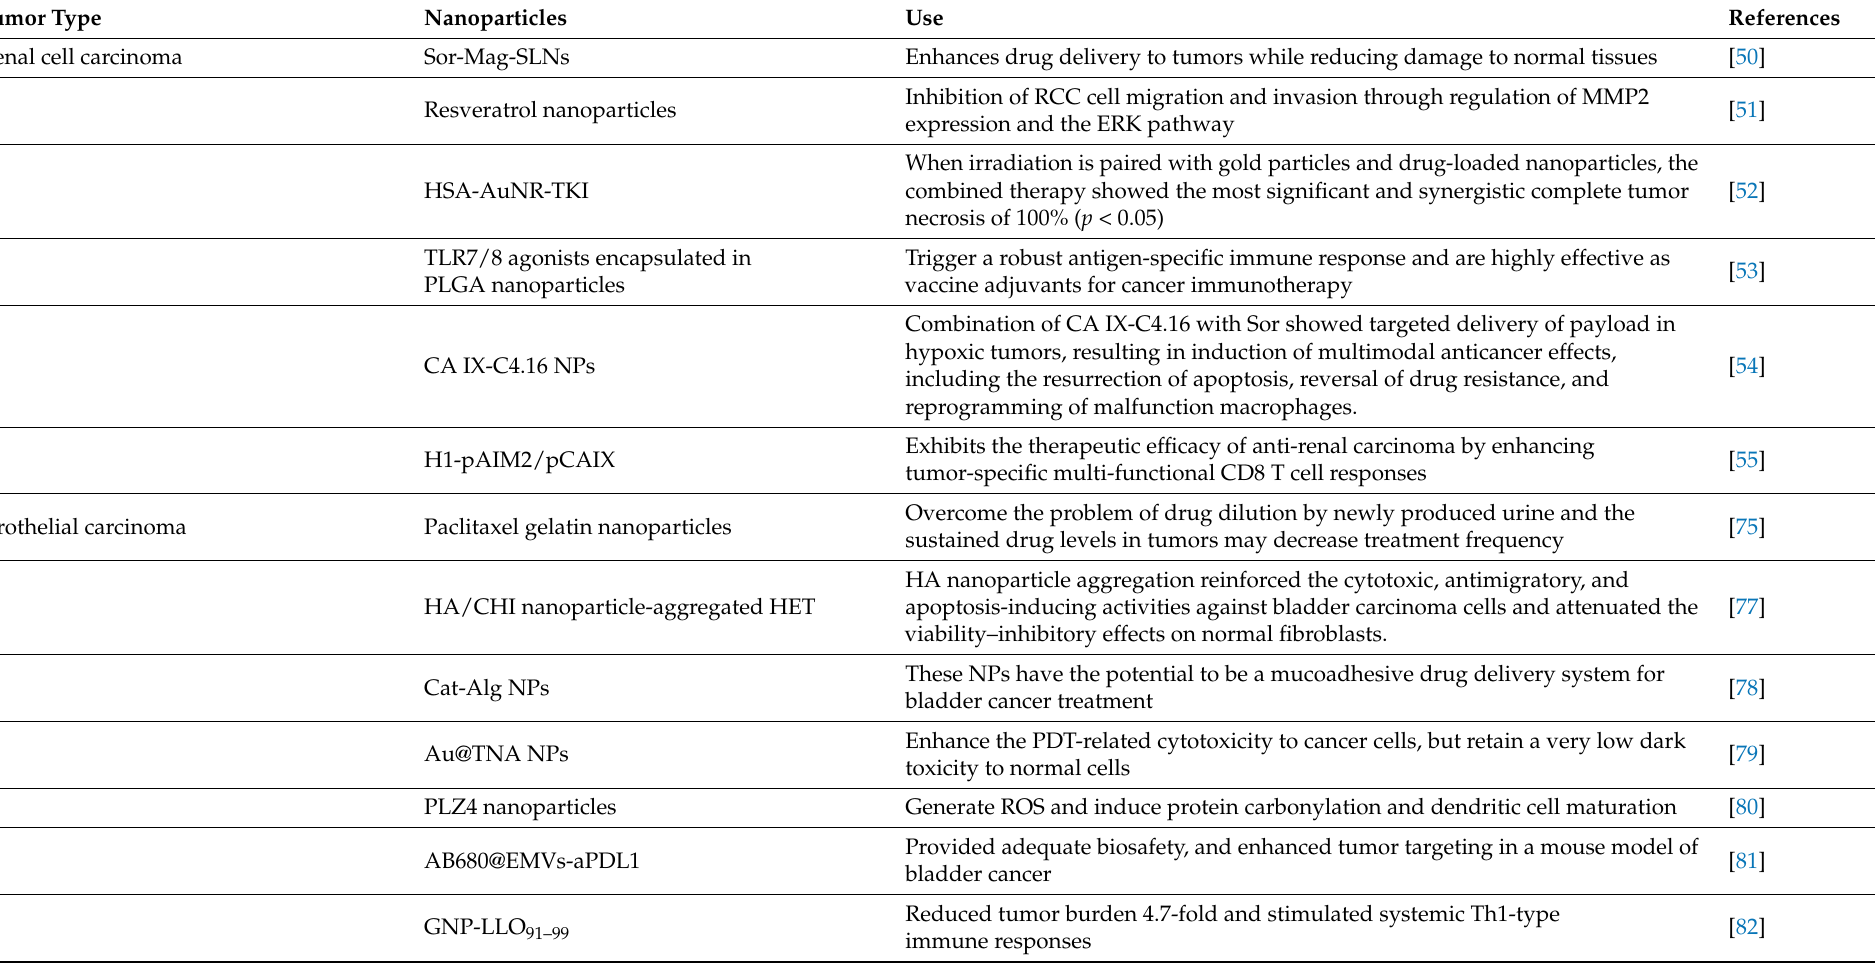
Table 1. The nanomedicines for the treatment of urological